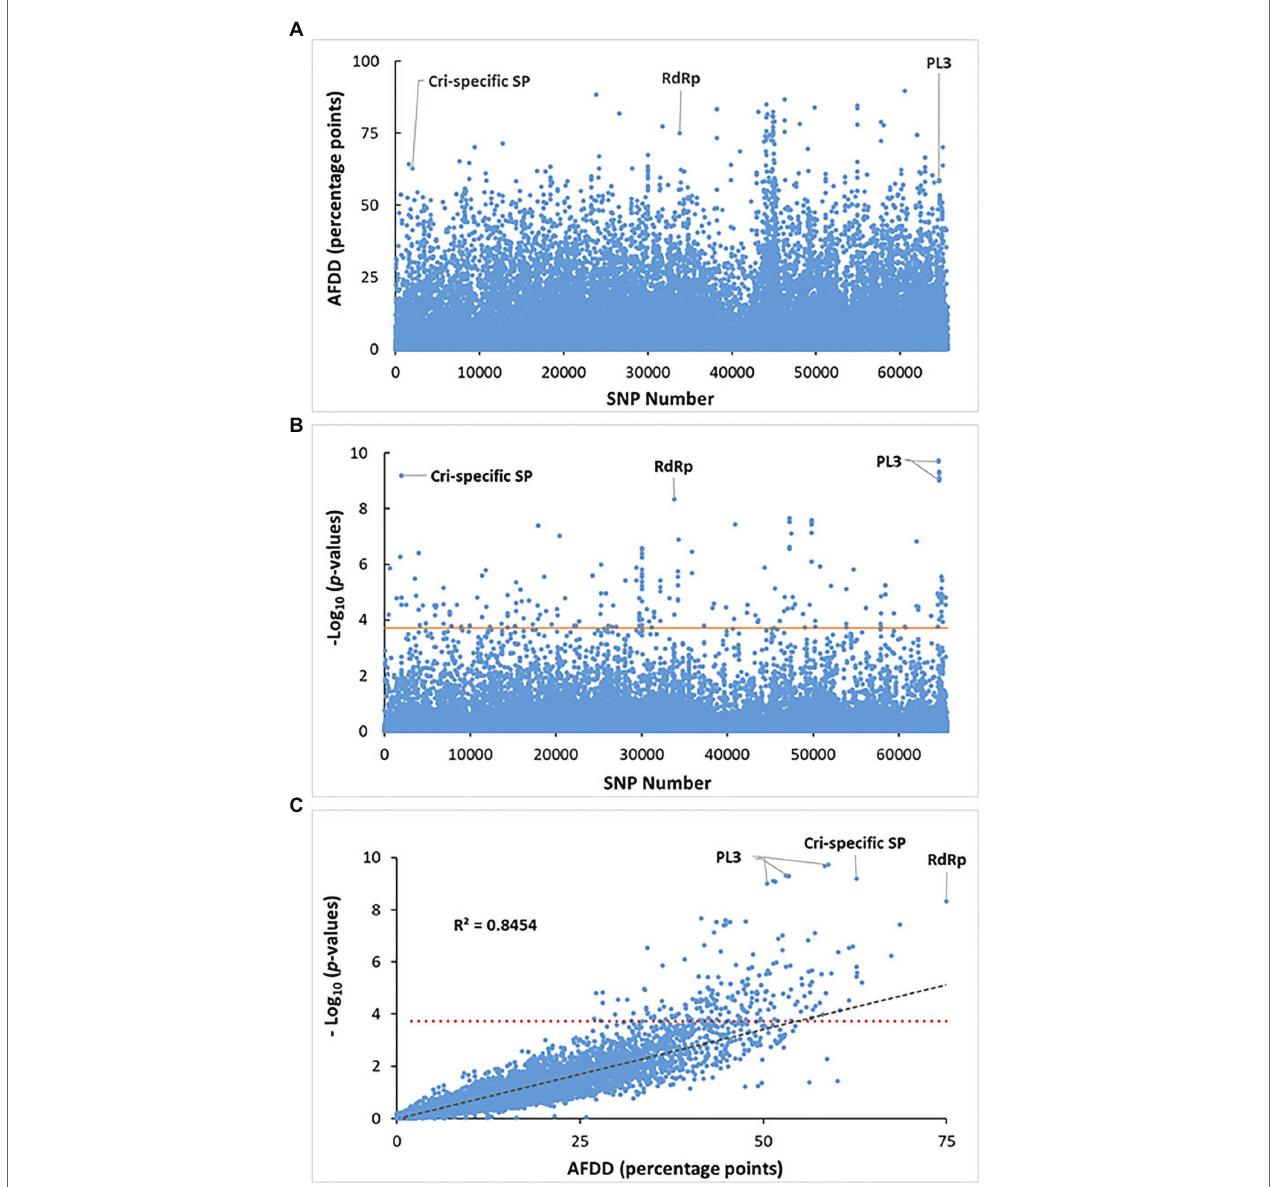
FIGURE 4 | Identification of SNP loci for significant association with the virulent phenotype. (A) Distribution of allele frequency directional difference (AFDD) across all tested 65,617 SNPs shared between the vcr2 and wild Avcr2 pools. About 3% of total SNPs showed AFDD >30. (B) Manhattan plot of association p -values across all tested 65,617 SNPs analyzed by XP-GWAS. Three genes are labeled to show their SNPs with association at the most significant levels. (C) Scatter plotting AFDD values against p values analyzed by XP-GWAS across all tested SNPs. The horizontal red lines in (B) and (C) indicates the FDR-corrected threshold of p = 2e-04 for SNP loci with significant association. The gray dashed line in (C) shows that FADD values are highly correlated with the p -values analyzed by XP-GWAS for the corresponding SNP